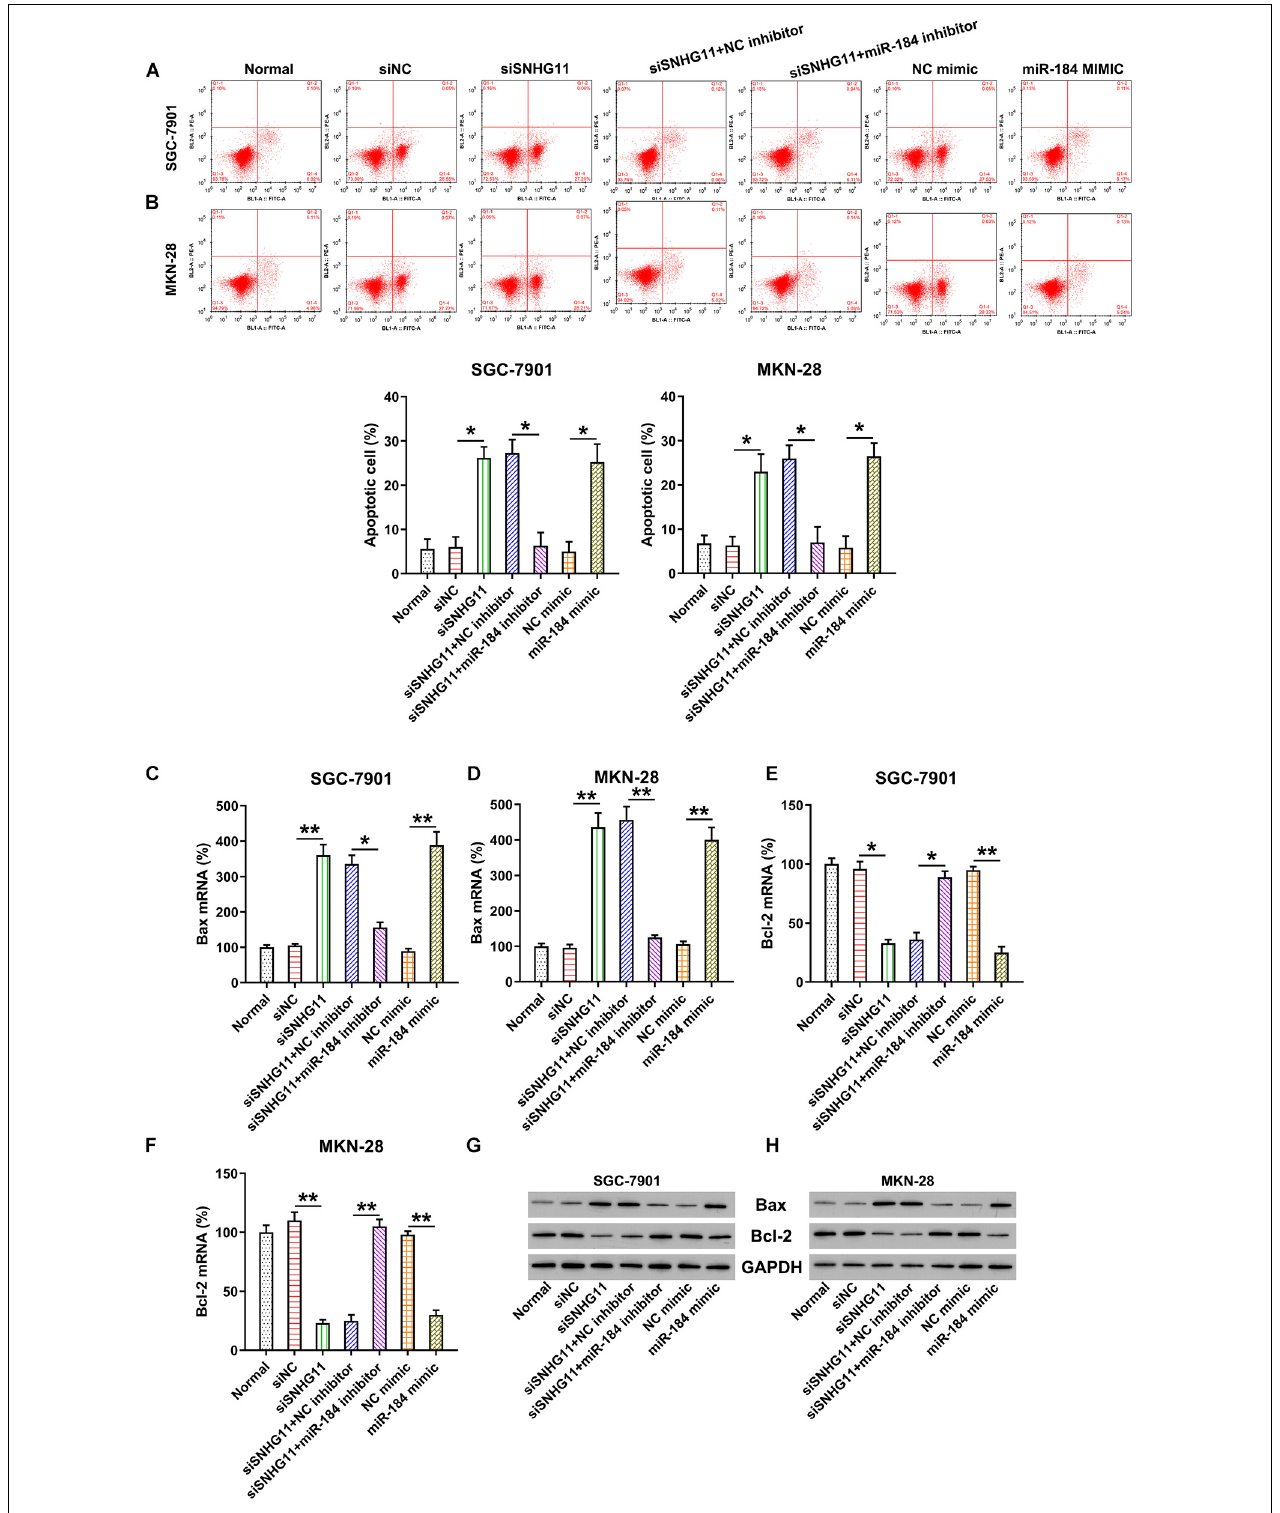
FIGURE 5 | The effect of SNHG11 and miR-184 on MKN-28 and SGC-7901 cells’ apoptosis. MKN-28 and SGC-7901 cells were subjected to NC shRNA, SNHG11 shRNA, SNHG11 shRNA + NC inhibitor, SNHG11 shRNA + miR-184 inhibitor, NC mimic, and miR-184 mimic for 36 h, or not. (A,B) Annexin V-FITC/PI FC results demonstrated the number of apoptotic cells. (C–F) qPCR assay and (G,H) Western blotting analysis were used to indicate the Bcl-2 and Bax mRNA and protein expressions in cells. “Normal” represents non-transfected cells. These data are shown as average ± SD . * P < 0.05, ** P < 0.01 vs. indicated groups.